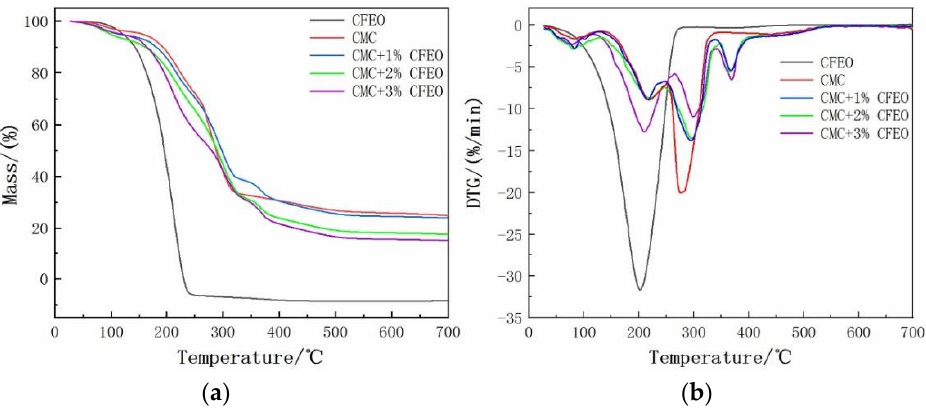
Figure 4. TGA ( a ) and DTG ( b ) curves for CFEO, CMC film, and blended CMC-CFEO films with various concentrations of CFEO.